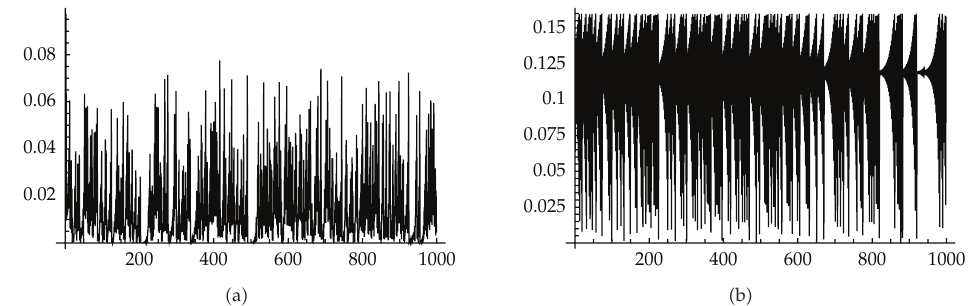
Figure 3: The picture shows the distance between the first 1000 iterates of two points for the